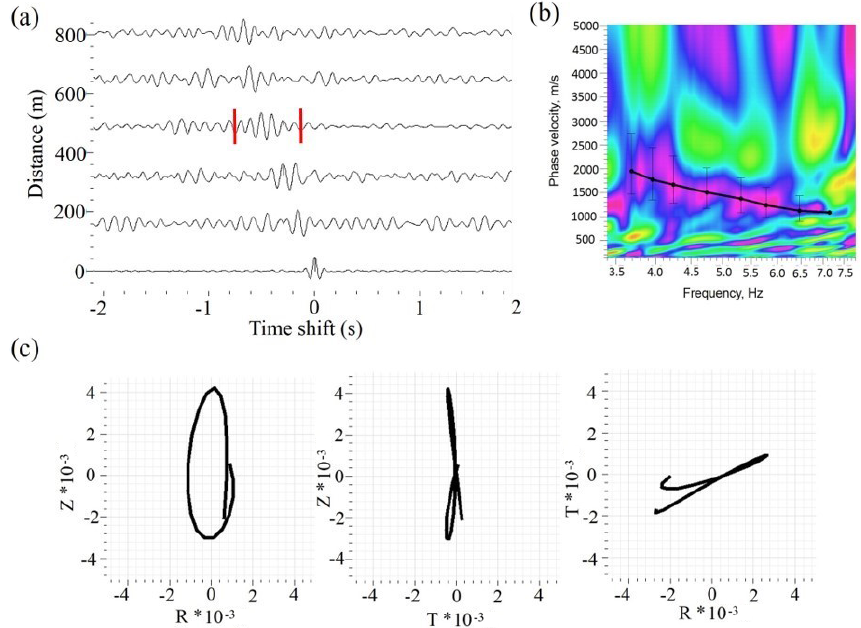
Figure 13. Example of EGFs with correspondent dispersion curve, obtained from passive seismic data: (a) EGFs on frequency band 3–8Hz; (b) dispersion curve, calculated from EGFs by the MASW technique; (c) particle motion diagrams of a surface wave part of an EGF indicated by red lines.